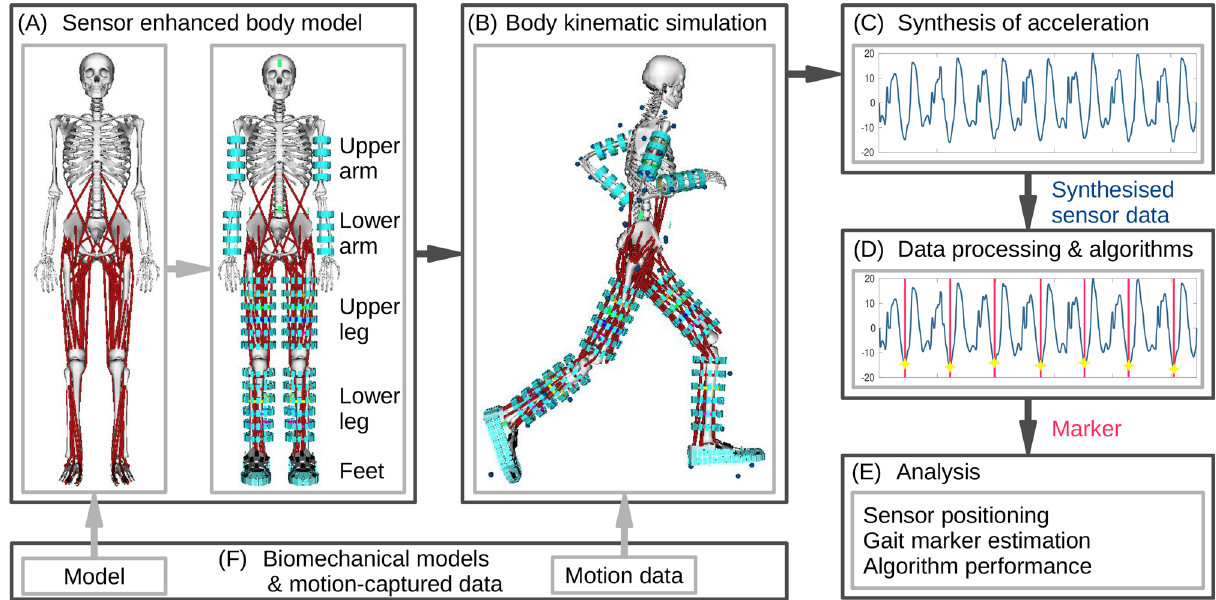
Figure 1. Human motion analysis using personalised biomechanical models, simulation, and data synthesis to estimate wearable system and marker performance. ( A ) Illustration of the personalised full body model, extended with motion sensor models at upper and lower body extremities. ( B ) Body kinematic simulation of the sensor-extended full body model with video motion-capture data. ( C ) Sensor data synthesis (here: acceleration) using a direct-link sensor-body attachment model. ( D ) Processing of synthesised acceleration data using gait marker estimation algorithms. ( E ) Analysis of individual movement effects on gait markers, sensor position on the body, and estimation algorithms. ( F ) Biomechanical models and video-motion data obtained from the public SimTK